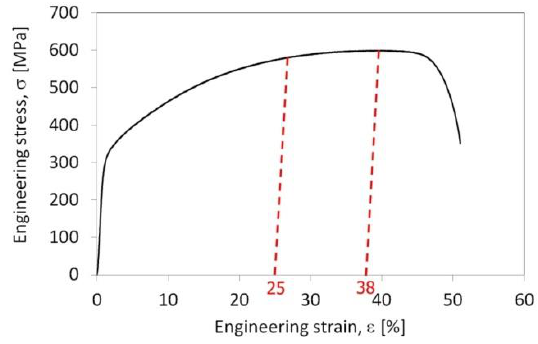
Figure 7. Representative engineering stress – strain diagram of as-received 316H steel indicating the selection of plastic pre-strain levels to be 25% and 38% in conformity with experimental design philosophy introduced in Figure 2.